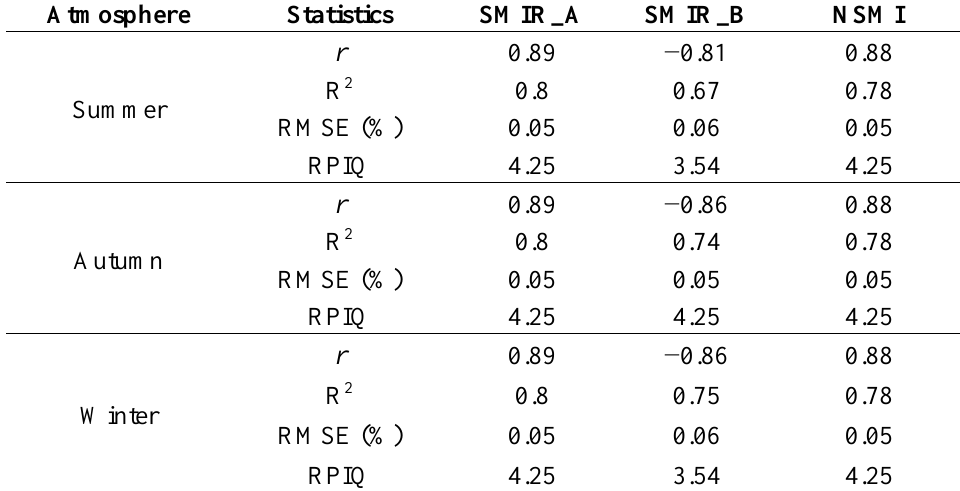
Table 3. Results from the application of SMIR and NSMI indices for the estimation of soil moisture from simulated PRISMA data, with the addition of simulated atmospheric effects for different seasonal